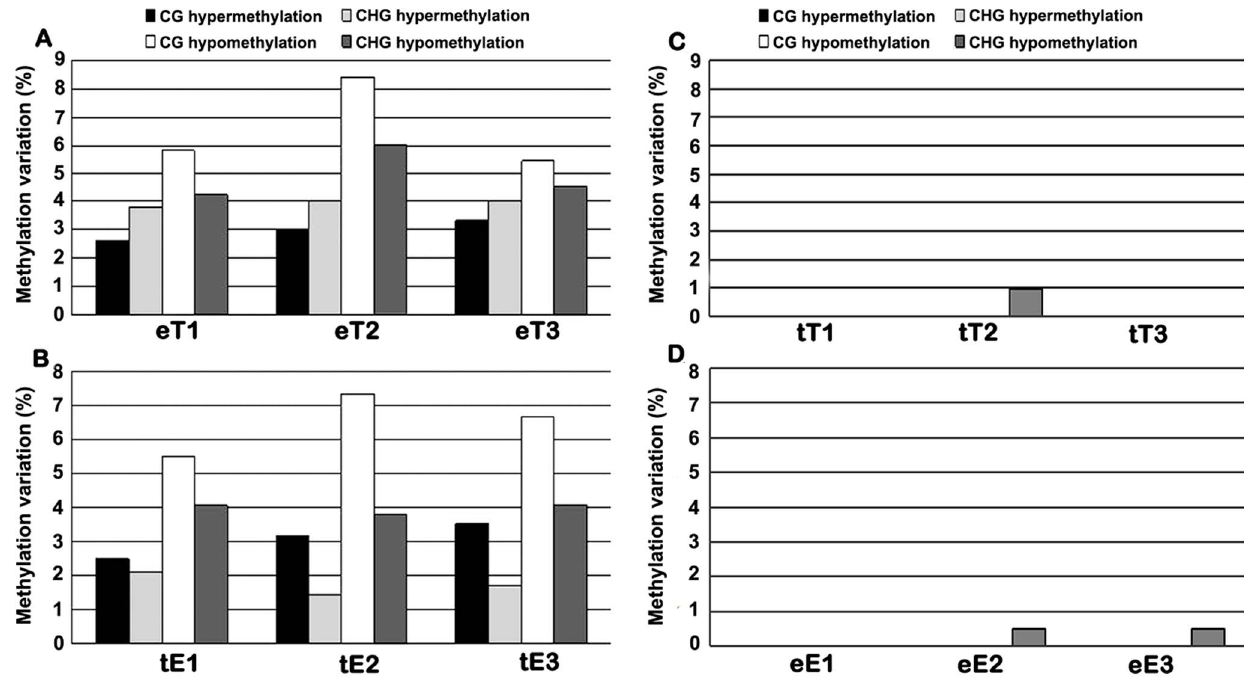
Figure 2. Tabulated data of alteration in DNA methylation patterns based on the MSAP analysis. Alterations in the four major methylation patterns, CG hyper, CHG hyper, CG hypo and CHG hypo, in three independent tomato scions hetero-grafted to eggplant (marked as eT) ( A ), three independent eggplant scions grafted to tomato (marked as tE) ( bB ), three independent self-grafted tomato scions ( C ), and three independent self-grafted eggplant scions ( D ) was calculated based on the MSAP data by comparing with their respective seed-plant controls of tomato and eggplant, respectively.